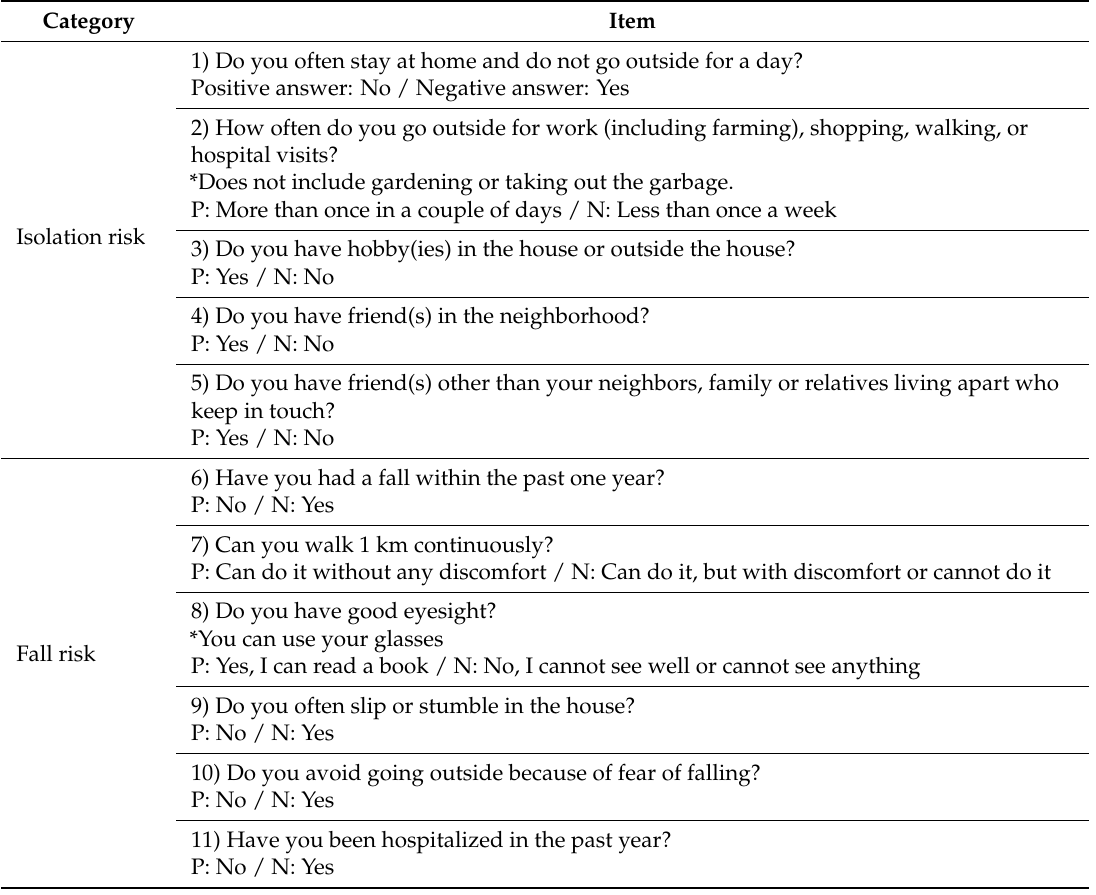
Table 1. The frailty index translated from Kaigo-Yobo Check-List [16,17]. Category